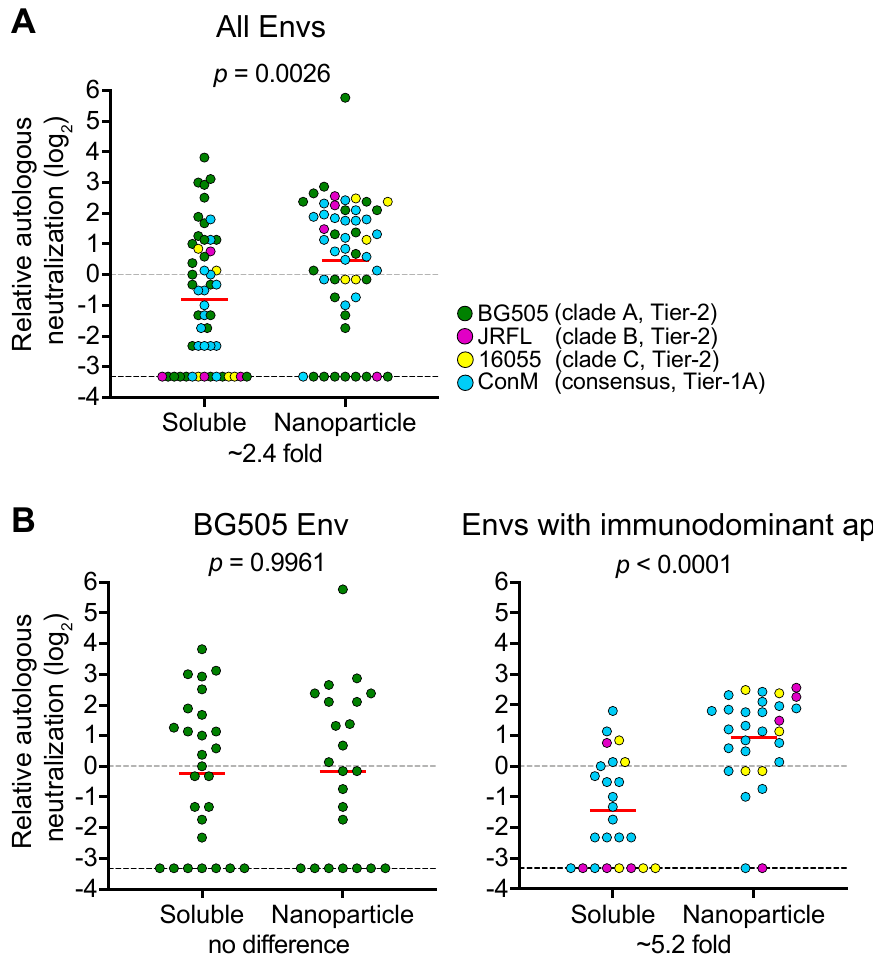
Figure 1. A meta-analysis comparing neutralizing responses induced by native-like Env trimers on nanoparticles or as soluble immunogens. The autologous neutralization data from rabbits and non-human primates were taken from the following studies: for BG505: [60,71,72,81]; for JRFL: [56]; for 16055 [59]; for ConM [74,81]. To avoid bias caused by differences in immunogenicity between these Envs, we first determined the geometric mean for each study at time of peak neutralization titer (i.e., two weeks after the last immunization). Subsequently, the relative neutralization titers of the individual sera were calculated using the geometric mean. When no neutralization was detected (i.e., 50% neutralization titer of <20), the value of this animal serum was set to 0.1. ( A ) NAb titers from animals immunized with BG505, JRFL, 16055 and ConM NPs or soluble Env. ( B ) NAb titers from animals only immunized with BG505 NPs or soluble Env (left); NAb titers from animals immunized with JRFL, 16055 and ConM NPs or soluble Env (right). Fold differences were calculated by comparing geometric means (denoted by horizontal red lines) between the two data sets. A Mann–Whitney U test was used to determine significance.